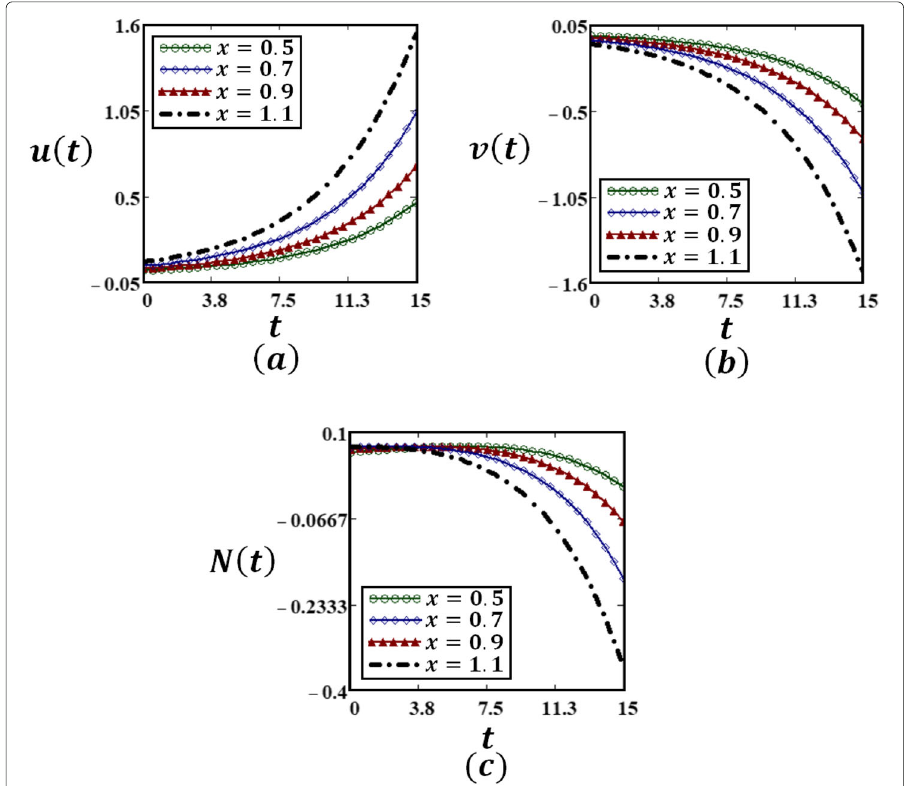
Fig. 2 Profiles of the velocity field u ( x , t ) , v ( x , t ) , and microrotation N ( x , t ) for MHD micropolar fluid given by Eqs. (32), (33), and (34), for U = 0.1, ν = 0.045, μ = 0.5, κ = 0.2, B 0 = 2, k ∗ = 0.2, σ = 0.2, j = 0.03, m = n = 1, y = 1, c 0 = 0.01, and different values of